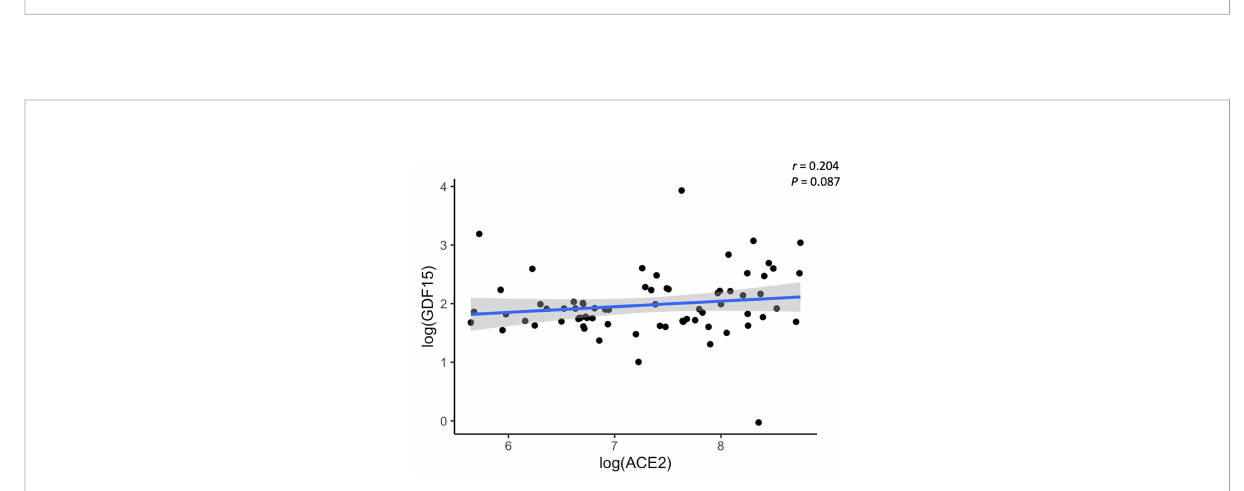
FIGURE 2 Representative scatterplot showing the association between GDF15 and ACE2 levels. Results of the 72 subjects are shown. Each dot represents an individual value. The solid blue line represents the regression line. The grey shade represents the con fi dence